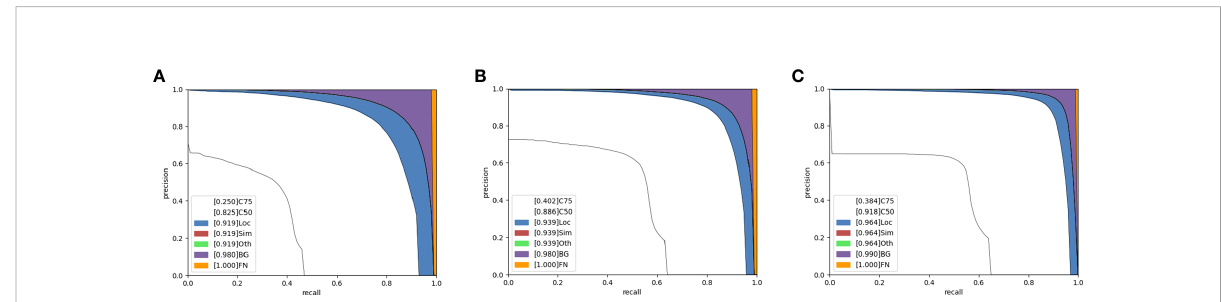
FIGURE 7 Precision – recall (PR) curves of WheatFormer with different backbones. (A) WheatFormer with convolutional neural network backbone. (B) WheatFormer with Swin Transformer backbone. (C) WheatFormer with MW-Swin Transformer backbone. C75: PR at threshold equals 0.75; C50: PR at threshold equals 0.50; Loc: PR at threshold equals 0.1, and location errors ignored without duplicate detections; Sim: PR after supercategory false positives are removed; Oth: PR after all class confusions are removed; BG: PR after all background false positive are removed; FN: PR after all remaining errors are removed.